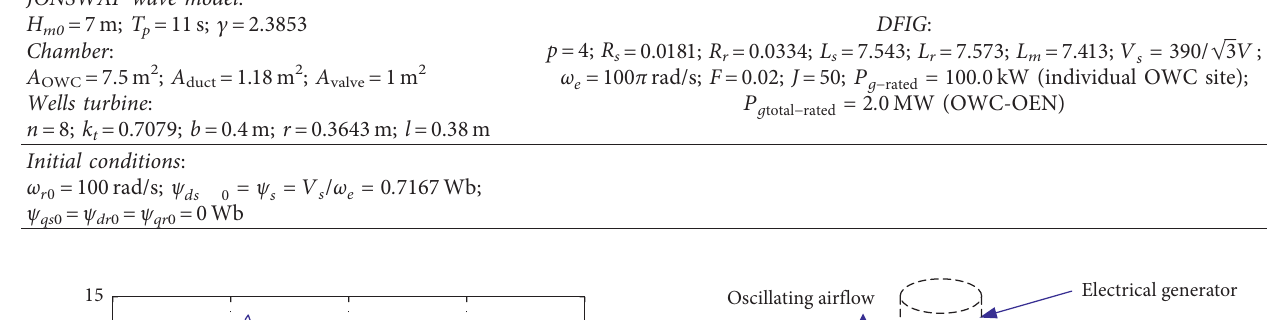
Table 1: JONSWAP wave model, OWC chamber, Wells turbine, and DFIG parameters. JONSWAP wave model :